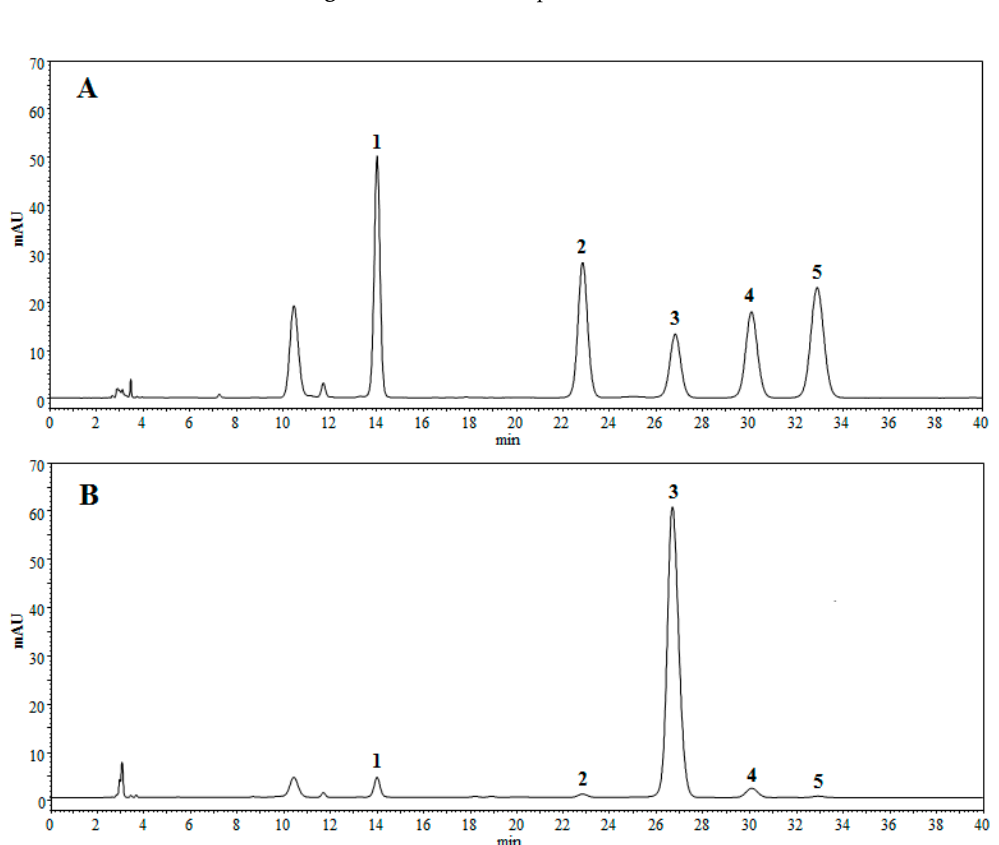
Figure 7. HPLC chromatograms of hydrolyzed polysaccharide derivatives. ( A ) HPLC chromatogram of monosaccharide standards; ( B ) HPLC chromatogram of PSA. (1) mannose, (2) galactose uronic acid, (3) glucose, (4) galactose, (5) arabinose.